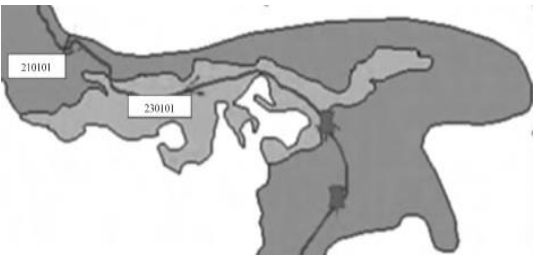
Figure 5. wrong combination of water surface pattern and background data river structure line